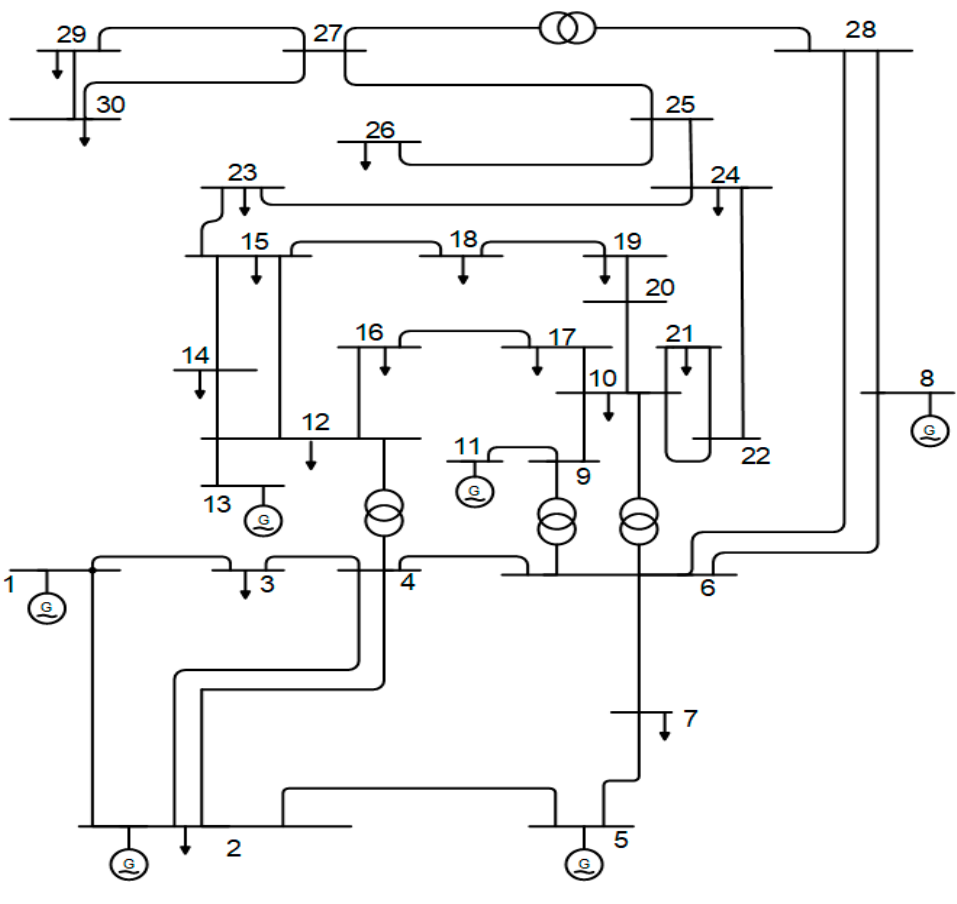
Figure 2. IEEE 30-bus grid [72]. Table 2. Optimal results for Case 1 of the IEEE 30-bus